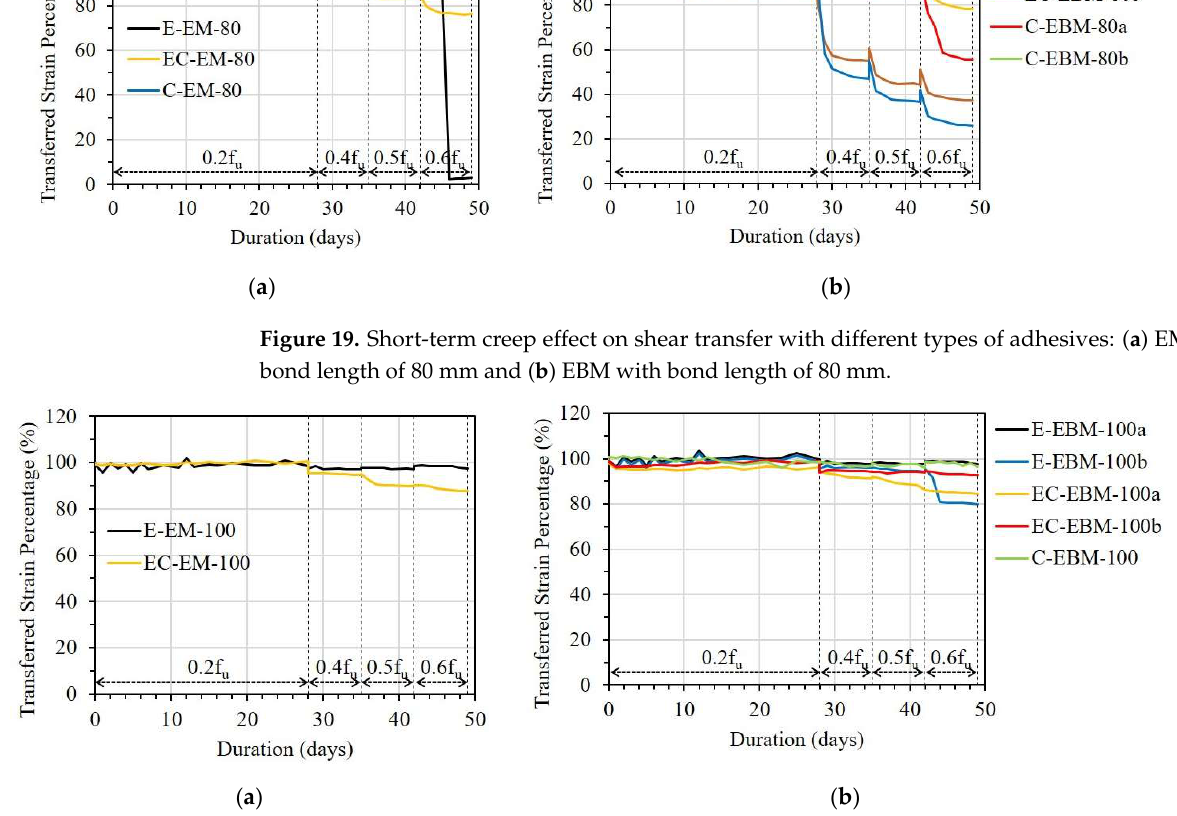
Figure 19. Short-term creep effect on shear transfer with different types of adhesives: ( a ) EM with bond length of 80 mm and ( b ) EBM with bond length of 80 mm.